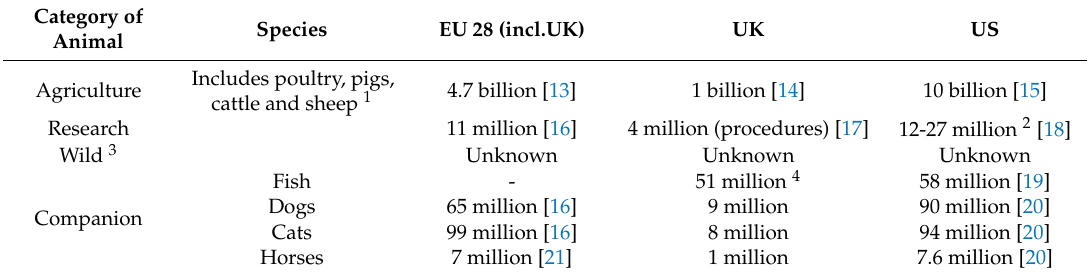
Table 1. Numbers of animals by category in the UK, EU and